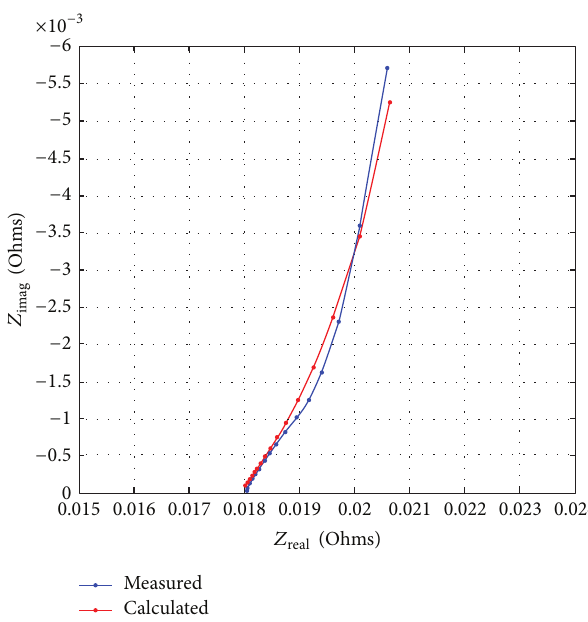
Figure 15: Complex-plane representation of a 400F ultracapacitor (values for the model calculation: 𝑅 1 = 0.01798 Ohm, 𝐶 1 = 420.5 F, = 0.007511 Ohm, 𝑅 = 0.0001291 Ohm, and 𝐶 = 10 F). 𝑅 2